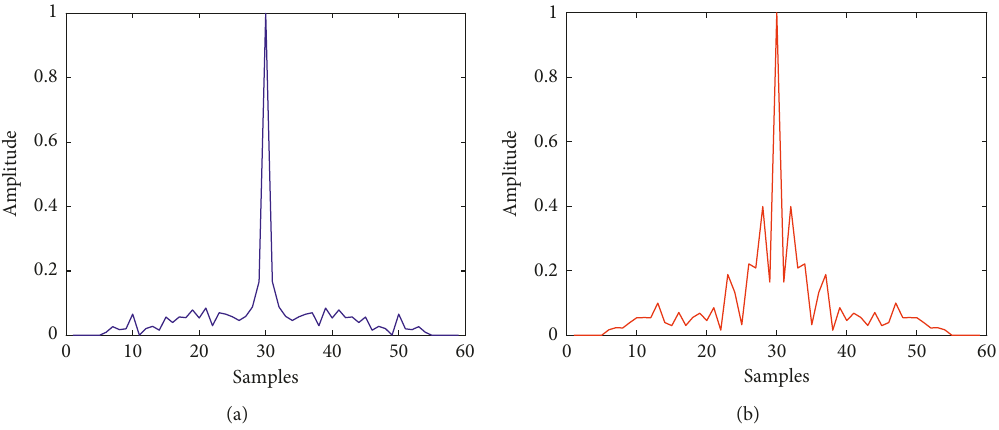
Figure 10: q function for experimental data sets: (a) VS01; (b)